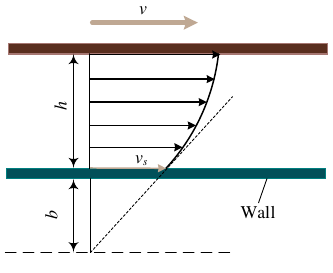
Figure 6. Schematic illustration of the navier slip